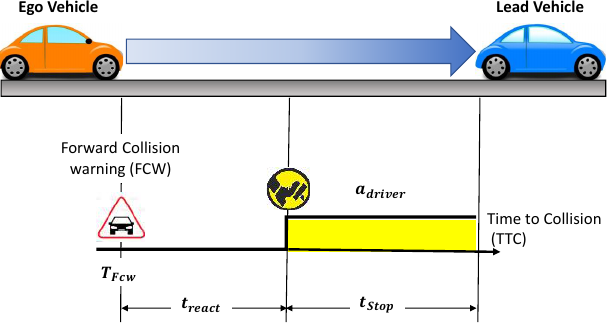
Figure 6. Forward collision warning system [31].